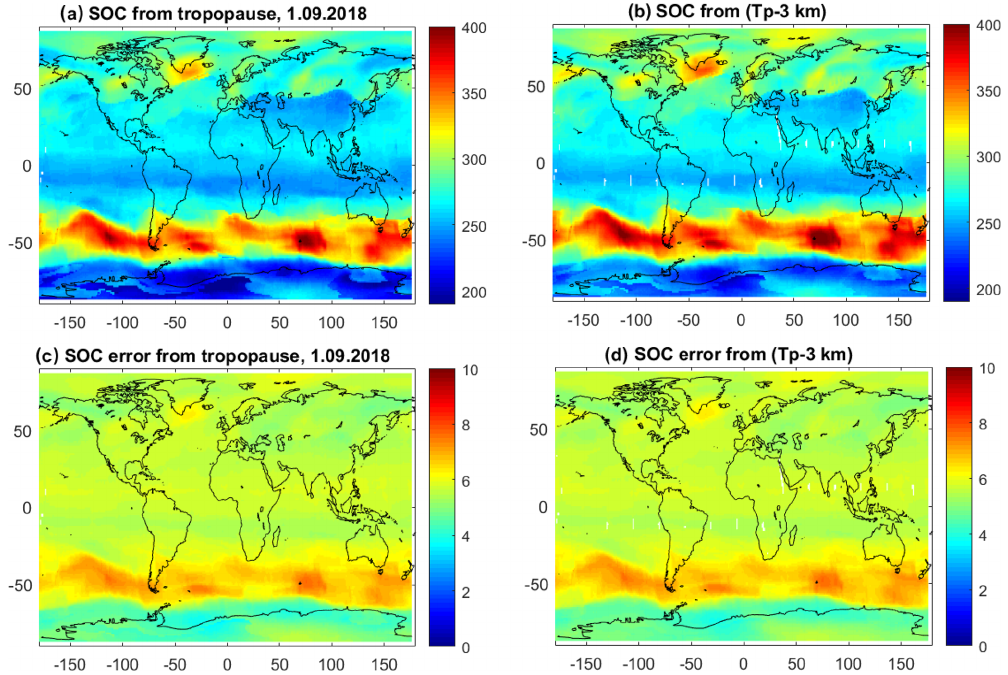
Figure 10. Stratospheric ozone column (DU) from the tropopause (a) and from 3km below the tropopause (b) computed from 1 ◦ × 1 ◦ merged (homogenized and interpolated) limb ozone profiles. The corresponding uncertainties are shown in panels (c) and (d) .